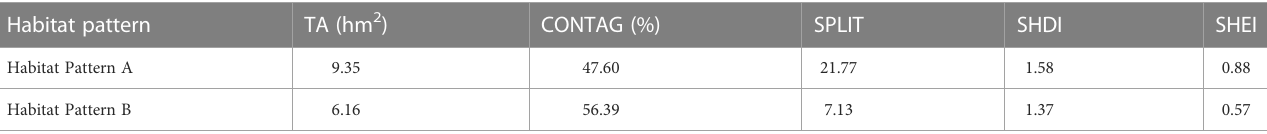
TABLE 5 Analysis of wetland habitat landscape patterns. Habitat pattern